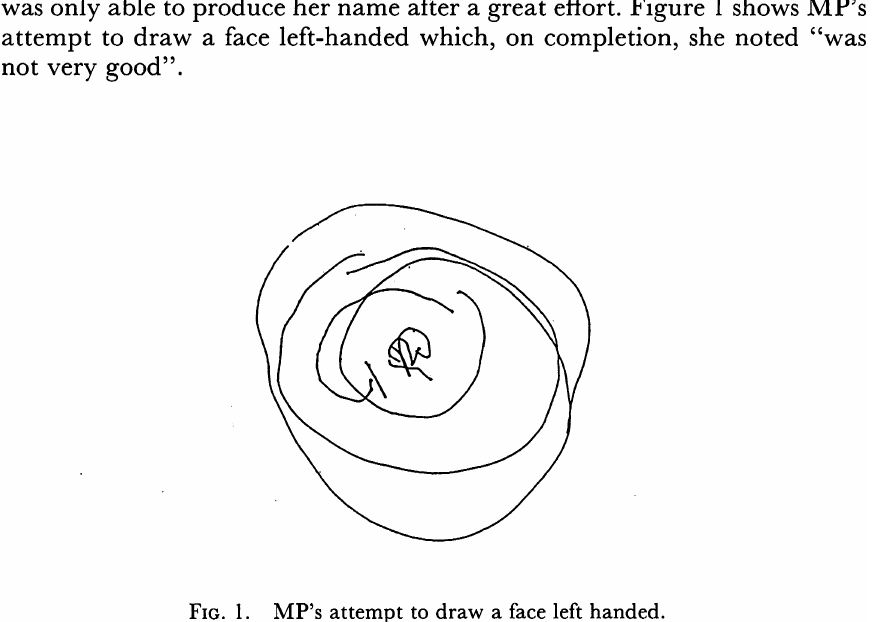
FIG. 1. MP's attempt to draw a face left